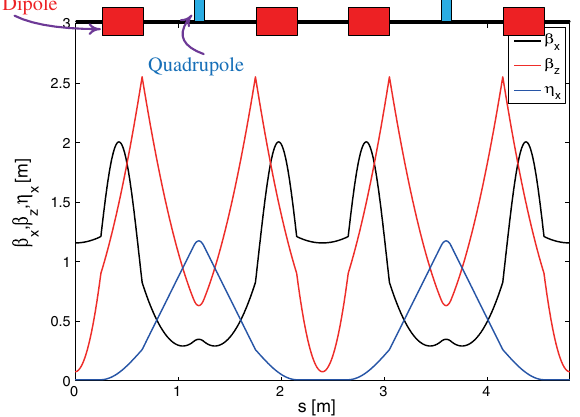
FIG. 4. The layout, betatron amplitude functions and dispersion function of the baseline design of the 4.8-m ring. The length of each dipole magnet is 0.4 m with bending angle 90°. The edge angles at both the entry and the exit of each dipole magnet are 37°. We consider iron magnet with 2.54 cm vertical gap. The first order fringe field effect is included with the FINT parameter of 0.9. The quadrupole focusing strength K 1 is 30 m − 2